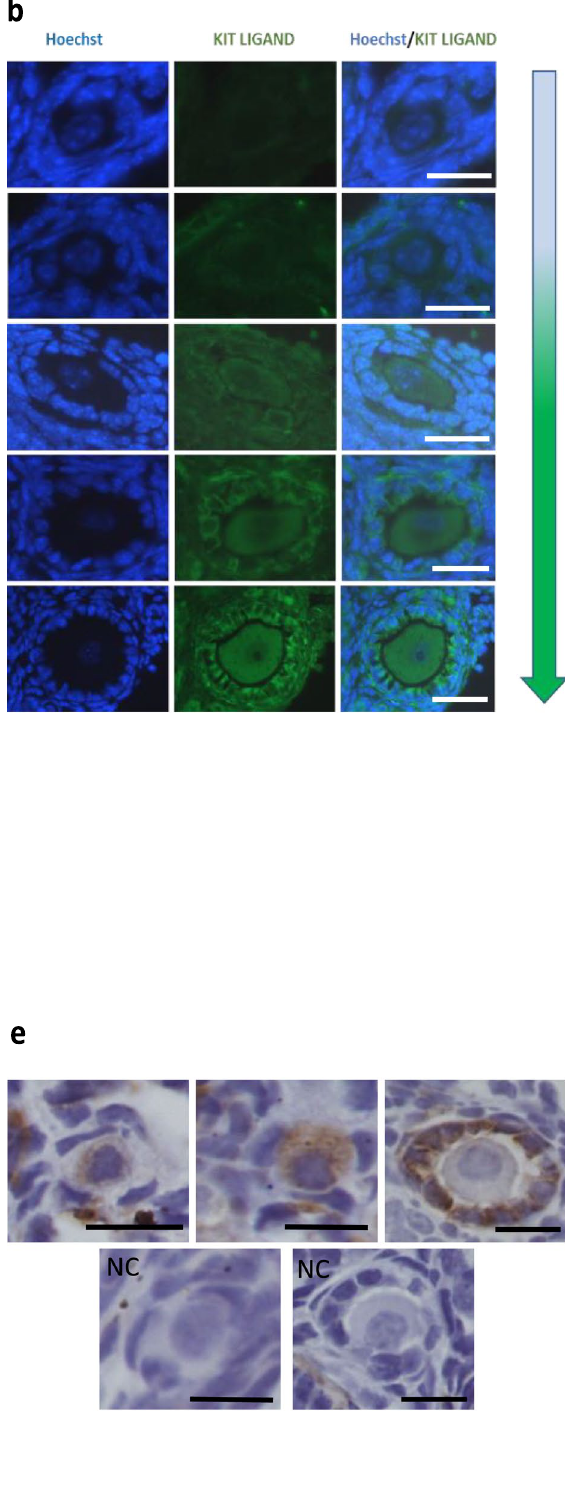
Figure 5. Follicular activation assessment following co-administration of carboplatin and paclitaxel to Brip1 +/ − and Brip1 +/+ mice. ( a ) Intensity of KIT LIGAND based on the signal of 20 randomly selected primordial and primary follicles per ovary (scale bar = 20 μm). ( b ) Illustration of the increasing KIT LIGAND staining intensity in primordial and primary follicles (scale bar = 20 μm). ( c ) Expression levels of Pten involved in follicular activation in the ovaries of Brip1 +/ − and Brip1 +/+ mice. ( d ) Percentage of p-RPS6 positive follicles. ( e ) Representative micrographs of p-RPS6-positive primary and primordial follicles. NC, negative control; scale bar 20 μm. Data are presented as mean ± SD; n = 5/treatment/genotype; *p < 0.05, **p < 0.01, ***p < 0.001, ****p <